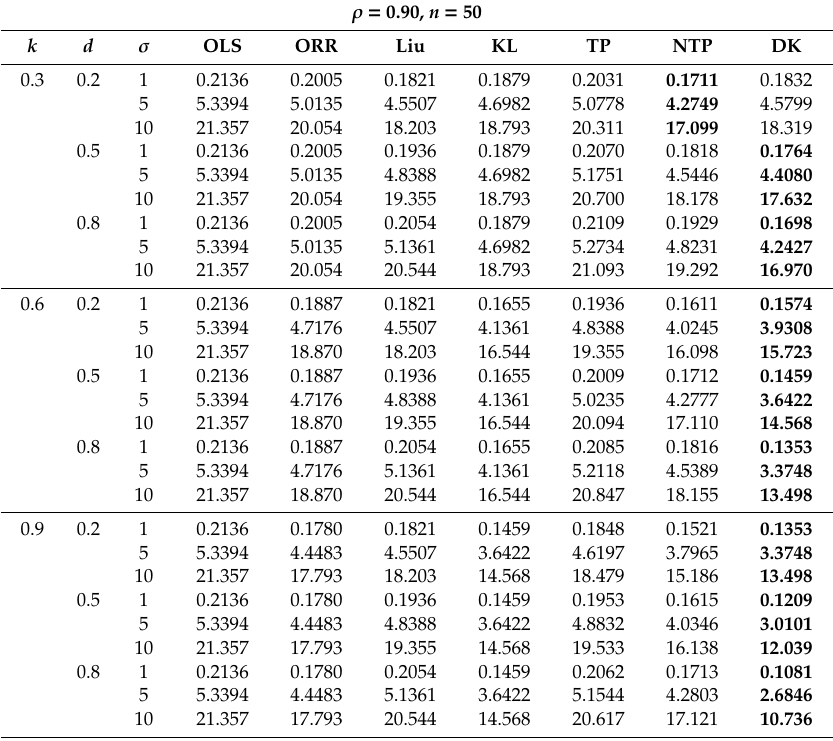
Table 1. Estimated MSE for ordinary least squares estimator (OLS), ordinary ridge regression (ORR), Liu, Kibria–Lukman (KL), two-parameter (TP), new two-parameter (NTP), and Dawoud–Kibria (DK). ρ = 0.90, n =